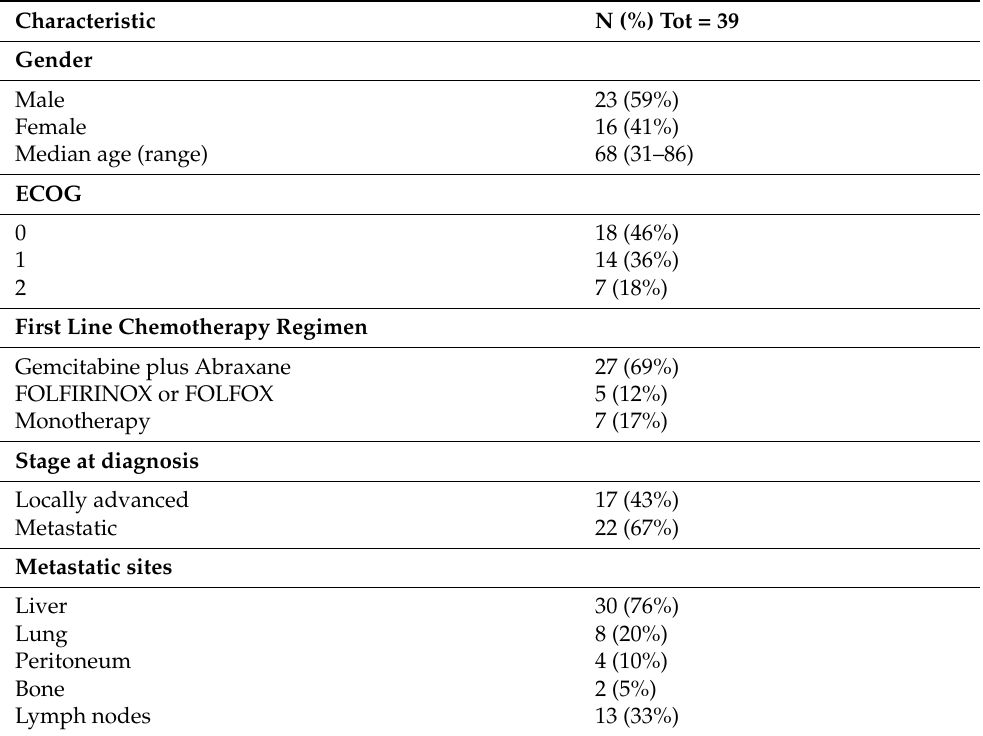
Table 1. Characteristics of the